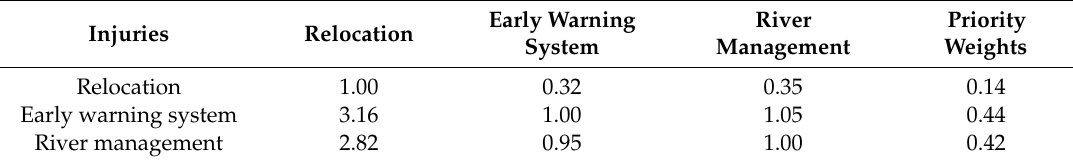
Table A1. Judgment matrix with respect to injuries reduction.